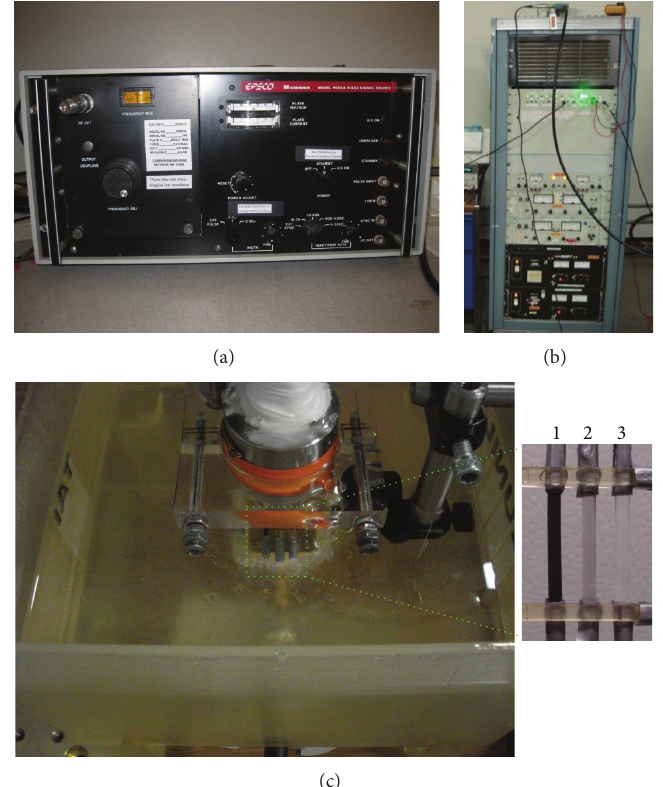
Figure 1: (a) Photograph of the 2.7–3.1 GHz tunable microwave source. (b) Photograph of the 7–9 GHz tunable microwave source (traveling wave tube oscillator). The amplified microwave output was connected to a waveguide (WR-90 for 7–9 GHz), which was secured to the bottom of the imaging tank. (c) Photograph of imaging tank and single-element focused US transducer. Highlighted region: photograph of sample consisting of solutions of (1) semiconducting SWNTs, (2) metallic SWNTs, and (3) a baseline of deionized water. All solutions were imaged in 3mm diameter polyolefin tubes. The solution of semiconducting SWNTs is darker than the solution of metallic SWNTs partly due to the higher nanoparticle concentration (300 ppm versus